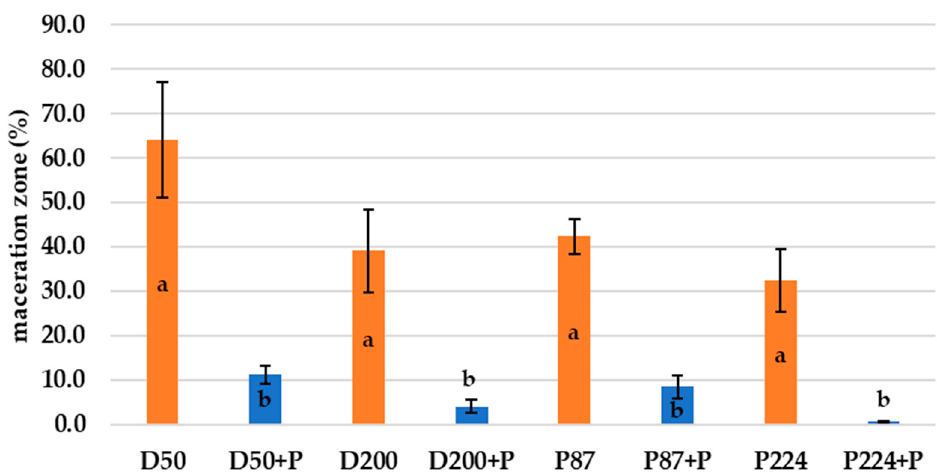
Figure 4. Maceration zones (%) of D. dianthicola (D50, D200) and P. carotovorum (P87, P224) rots on potato slices after 72 h at 25 °C; +P–phage treated; columns represent the means and the error bars represent the standard deviations; means with different lowercase letters (a or b) are significantly different between the control and phage-treated samples ( p < 0.05).